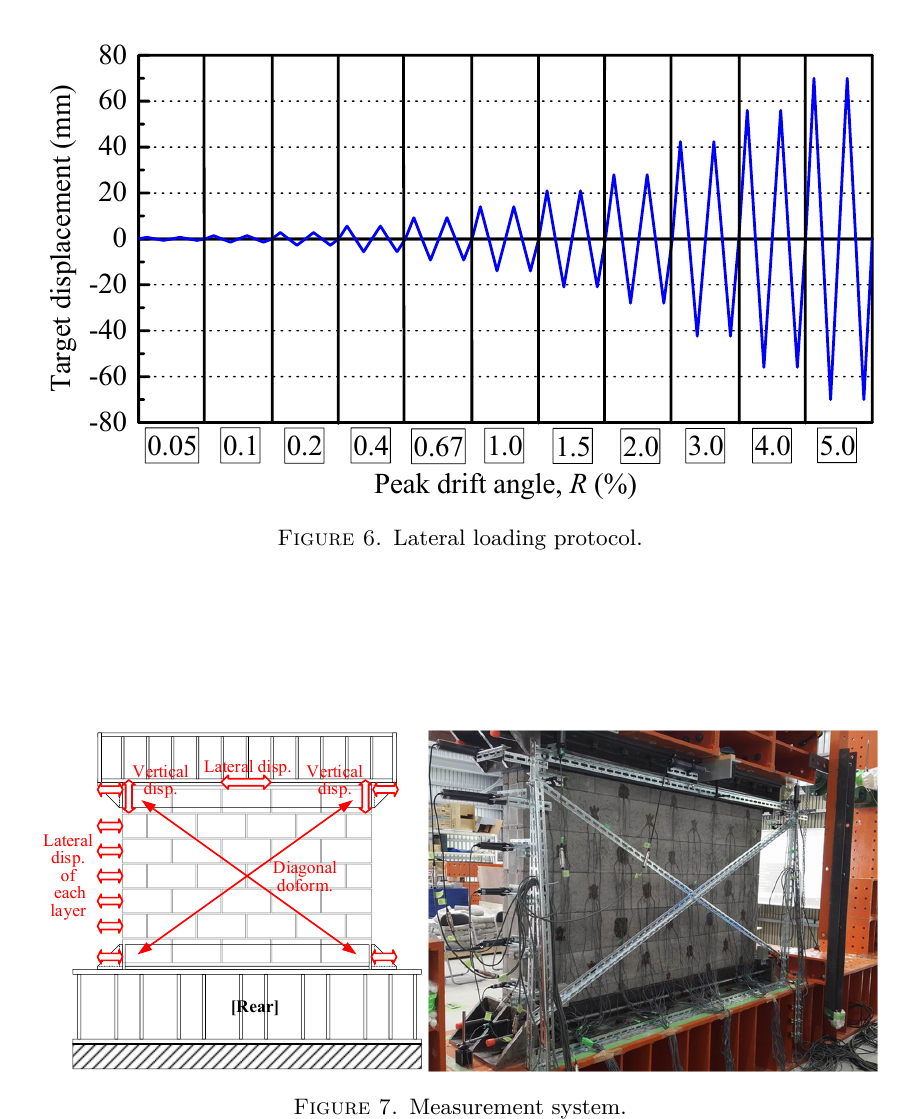
Figure 7. Measurement system.